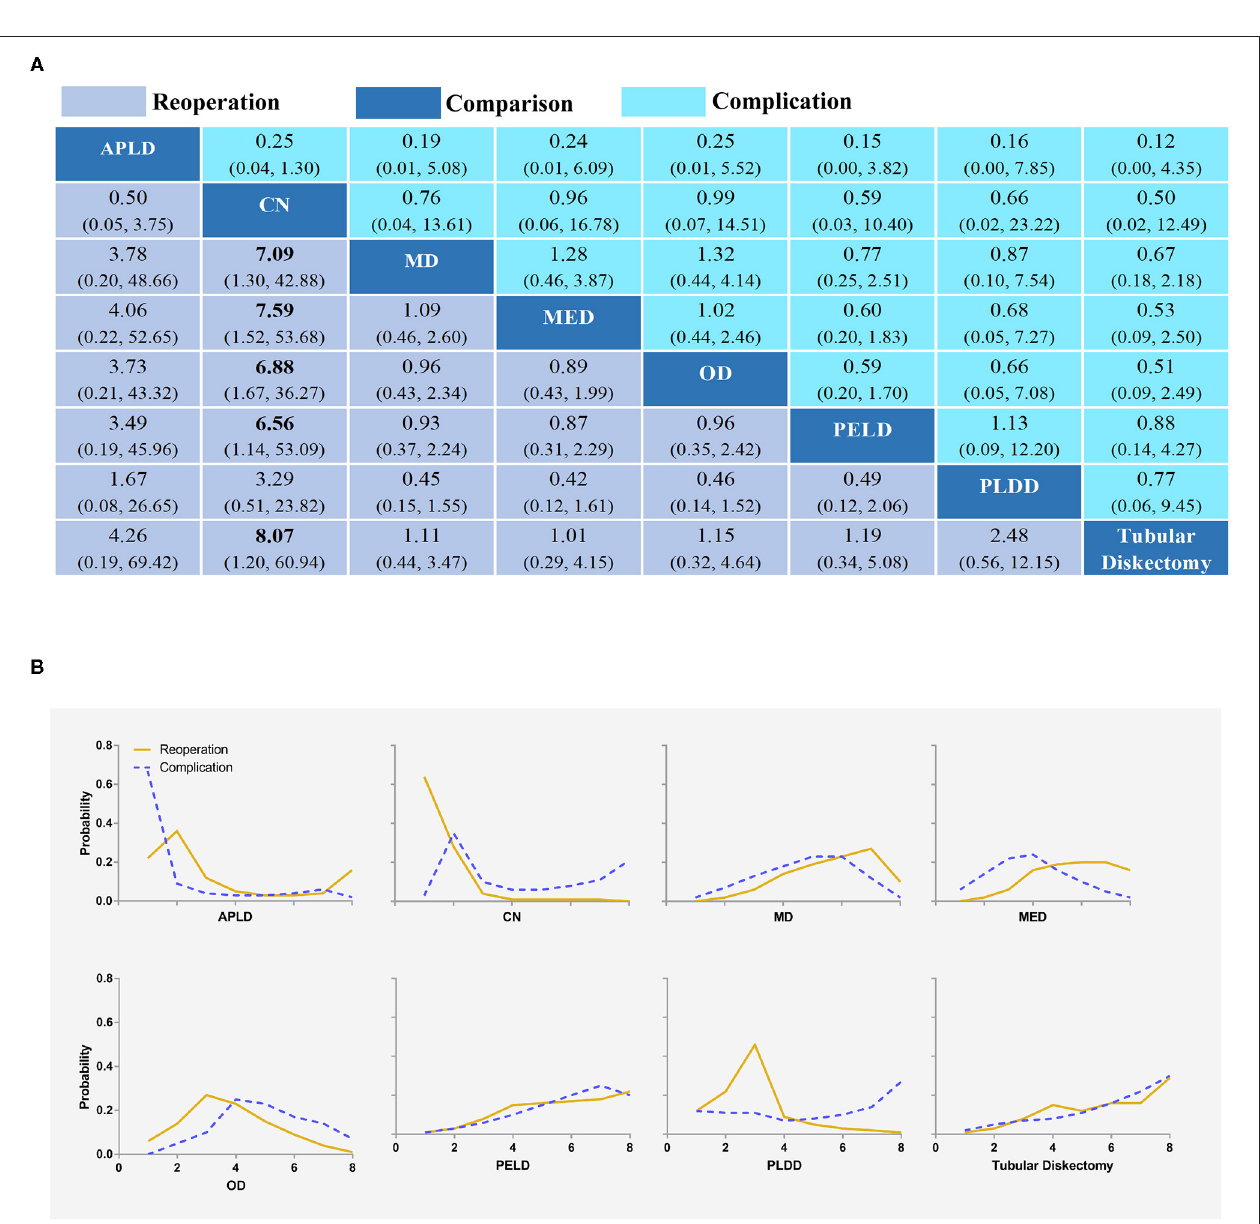
FIGURE 4 | Overall complication and reoperation (A) and the rank possibility of overall complication and reoperation (B) based NMA in the consistency model. Each cell of the profile contained the pooled OR and 95% credibility intervals for disability change; significant results were in bold. APLD, Automated percutaneous lumbar discectomy; CN, Chemonucleolysis; MD, Microdiscectomy; MED, Micro-endoscopic discectomy; OD, Open discectomy; PELD, Percutaneous endoscopic lumbar discectomy; PLDD, Percutaneous laser disc